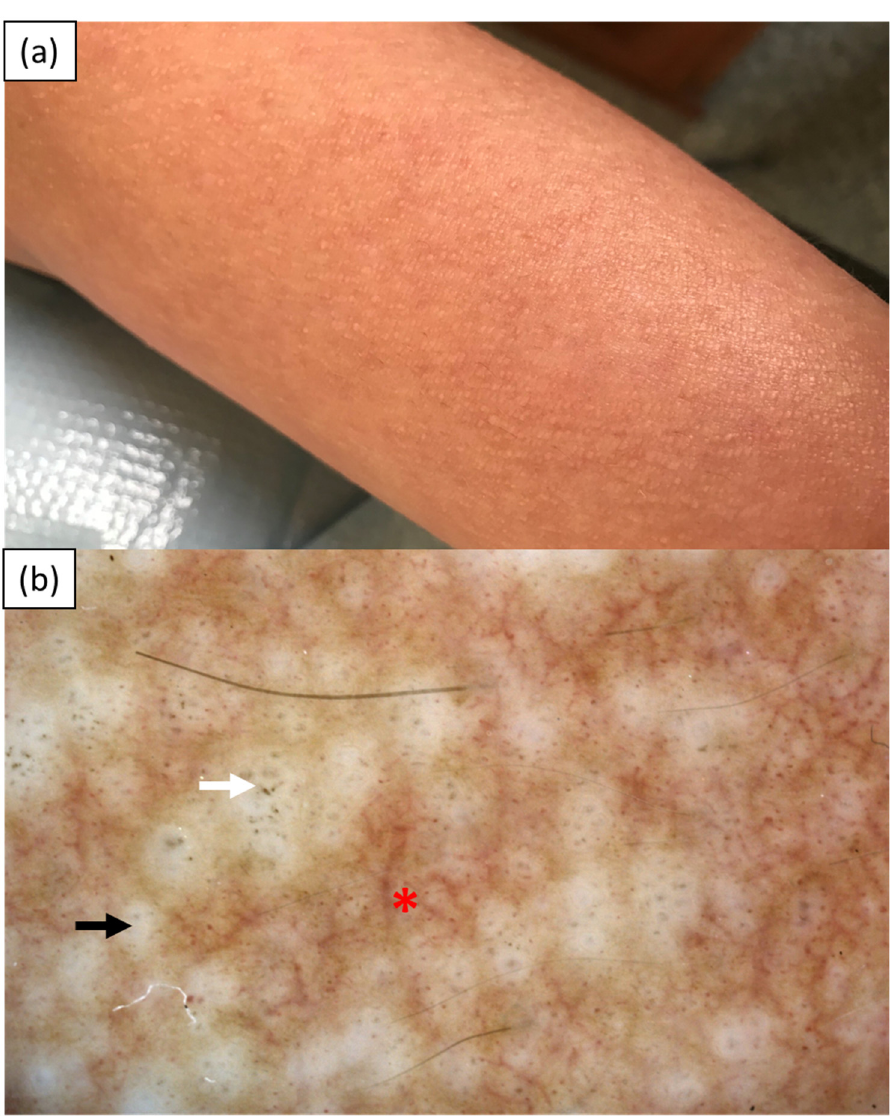
Figure 3. Case 3—( a ) discrete skin-colored papules on the left forearm; ( b ) videodermoscopy (Can- field D200 EVO ) showing central white hubs arranged in a linear manner (black arrow) with greyish dots (white arrow) and branching and dotted vessels in between (red asterisk).